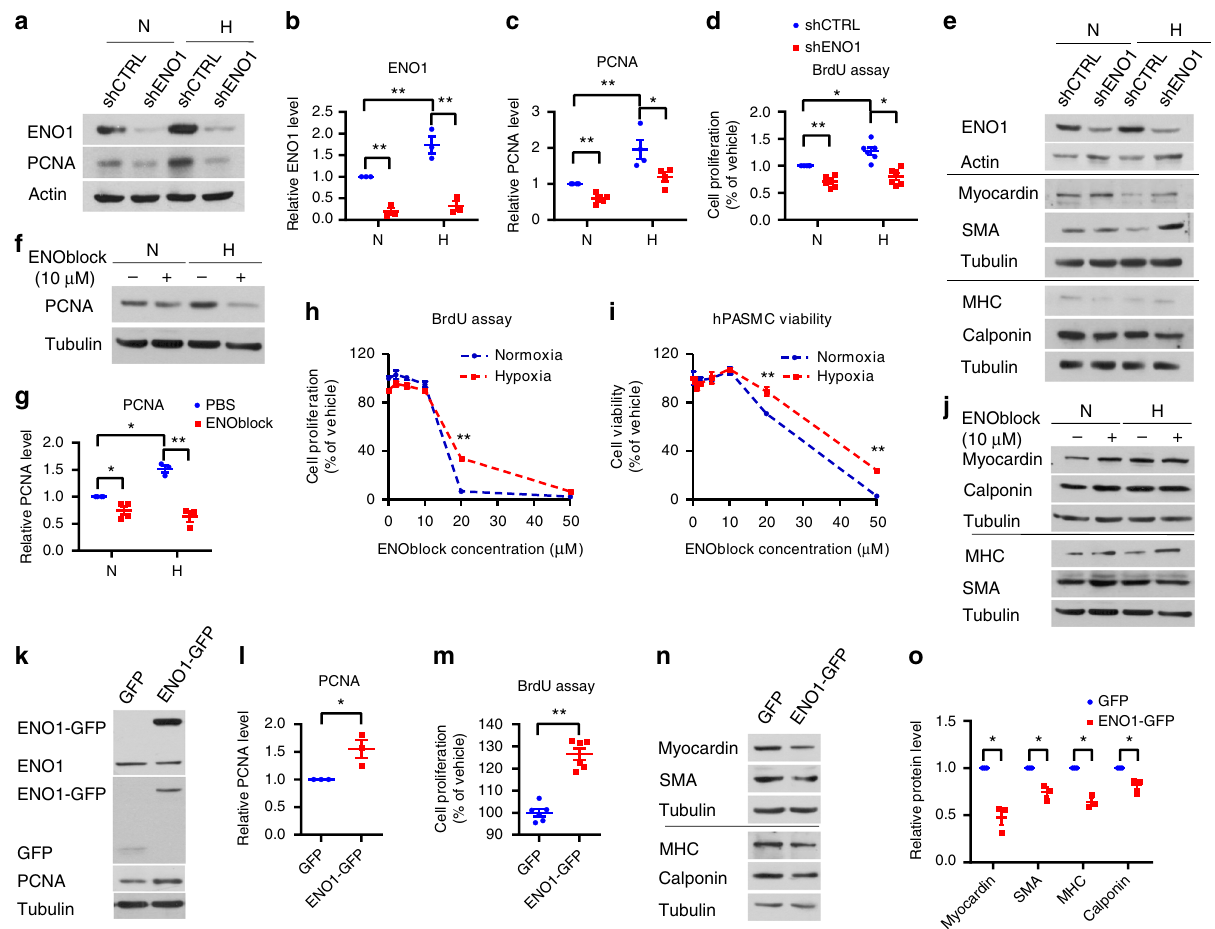
Fig. 2 ENO1 promotes proliferation and suppresses expression of contractile proteins in PASMC. a – c Normal PASMCs were transfected with lentivirus containing shRNA targeting ENO1 to silence ENO1 (shENO1). The shENO1 and control (shCTRL) PASMC were treated with hypoxia (1% O 2 ) for 24 h. We measured the expression level of ENO1 and PCNA by western blotting in cell lysates of shCTRL and shENO1 – PASMC under normoxic and hypoxic conditions a . b shows the normalized quanti fi cation of ENO1 levels ( n = 3 per group, ** P < 0.01). c shows the normalized quanti fi cation of PCNA levels ( n = 3 per group, * P < 0.05, ** P < 0.01). d BrdU assay was used to measure the cell proliferation in shENO1 – PASMC under normoxic and hypoxic conditions ( n = 6, ** P < 0.001). e Western blotting images of contractile proteins (Myocardin, SMA, MHC, and Calponin) in shCTRL and shENO1 – PASMC under normoxic and hypoxic conditions. f PASMC were treated with 10 μ M ENOblock and hypoxia (1% O2) for 24 h, and the PCNA levels were measured by western blotting. g Normalized quanti fi cation of PCNA level in ENOblock-treated PASMCs under normoxic and hypoxic conditions ( n = 3 – 4 per group, * P < 0.05, ** P < 0.01). h PASMCs were treated with ENOblock (in gradient concentrations) and hypoxia (1% O 2 ) for 24 h, afterwards the cell proliferation (using BrdU assay) and i cell viability were measured ( n = 4 per group, * P < 0.05, ** P < 0.01). j PASMC were treated with 10 μ M ENOblock and hypoxia (1% O 2 ) for 24 h, the levels of SMC contractile proteins (Myocardin, Calponin, MHC, and SMA) were measured by western blotting. k PASMCs were transfected with pCMV3-ENO1-GFP. The transfection ef fi ciency was determined by the detection of GFP and GFP-tagged ENO1 by GFP antibody and the overexpression of ENO1 was validated by ENO1 antibody (ENO1 and ENO1-GFP). The PCNA levels were also measured after overexpression of ENO1. l Normalized quanti fi cation of PCNA level in PASMC transfected with pCMV3-ENO1-GFP ( n = 4 per group, * P = 0.0202). m BrdU assay of ENO1- overexpressed PASMC ( n = 6 per group, ** P < 0.0001). n Western blotting images and o normalized quanti fi cation of SMC contractile